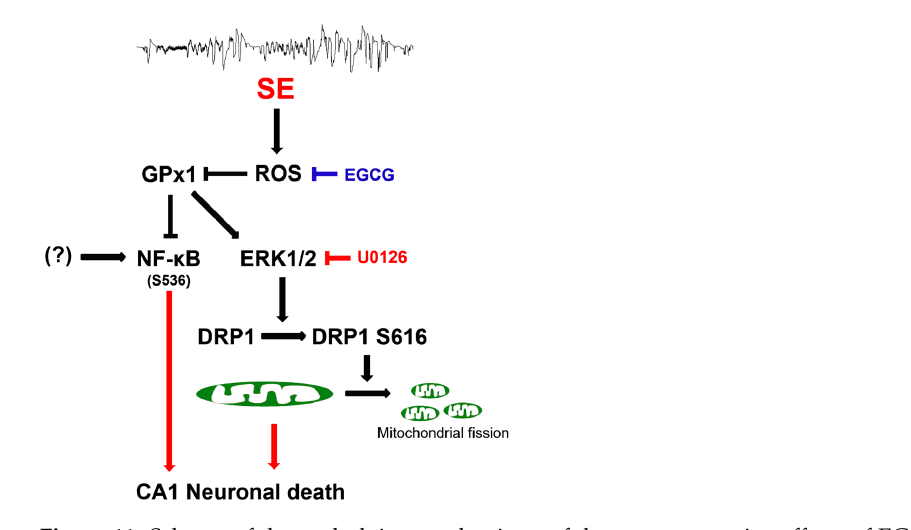
S2: Full-length gel images of Western blot data in Figure 4A. Figure S3: Full-length gel images of Western blot data in Figure 6A. Figure S4: Full-length gel images of Western blot data in Figure 8A.